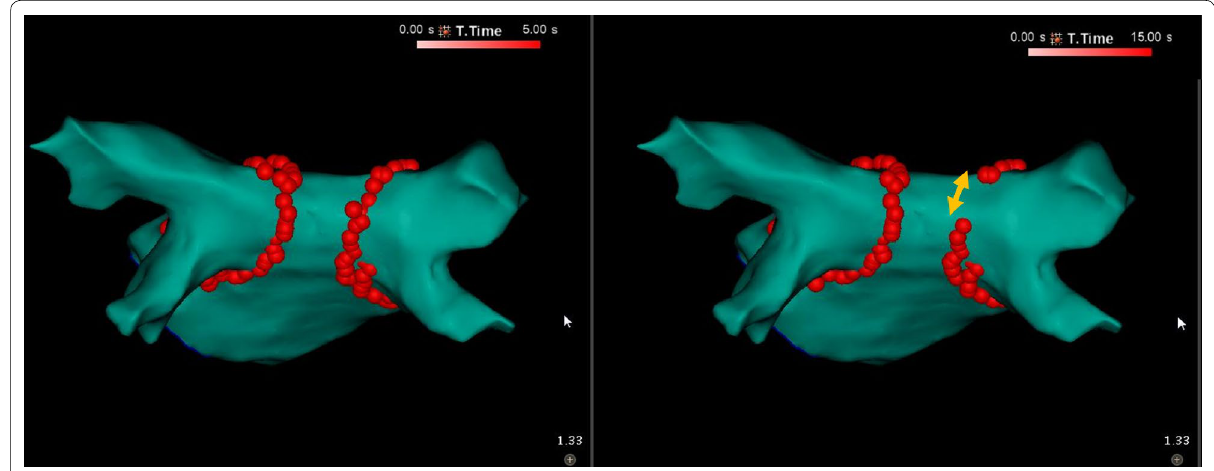
Fig. 2 Representative case of gap analysis. There were no gaps when using Criterion 1 (left), but gaps were noted when Criterion 2 was applied